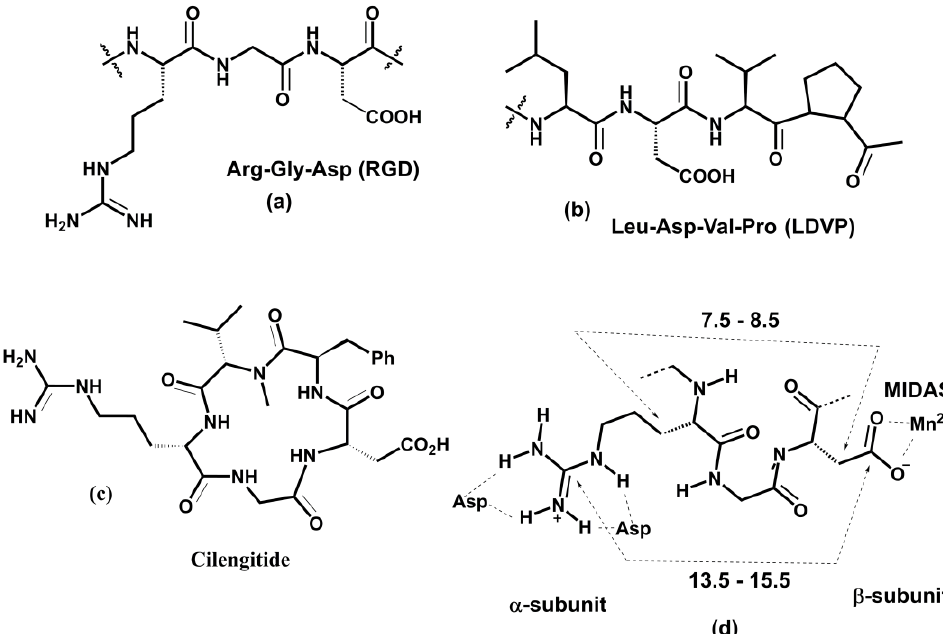
Figure 12. Schematic representation of ( a ) Arg-Gly-Asp (RGD), ( b ) Leu-Asp-Val-Pro (LDVP) integrin-binding motifs, ( c ) cyclic peptide RGD inhibitor cilengitide, and ( d ) key structural features of RGD-binding site.